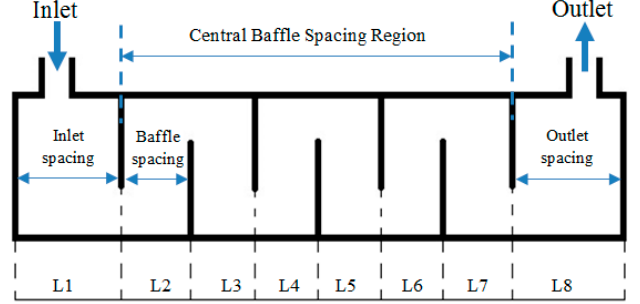
Figure 2. The dimensions of baffle spacing lengths for all cases.